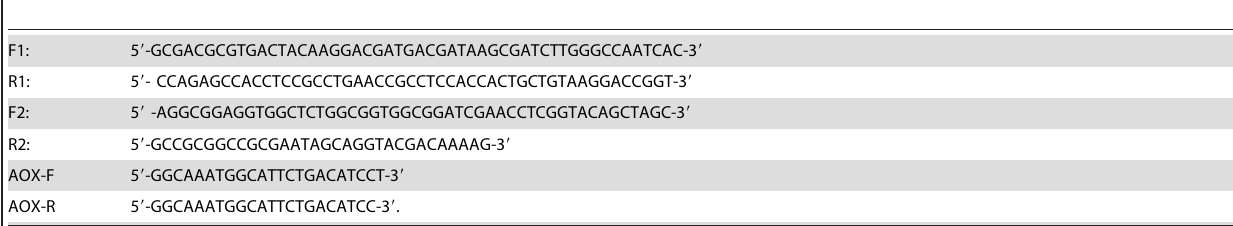
Table 1. Primers used for cloning bmace and AG a 1 genes and generating the synthetic gene encoding bmace-AG a 1 fusion